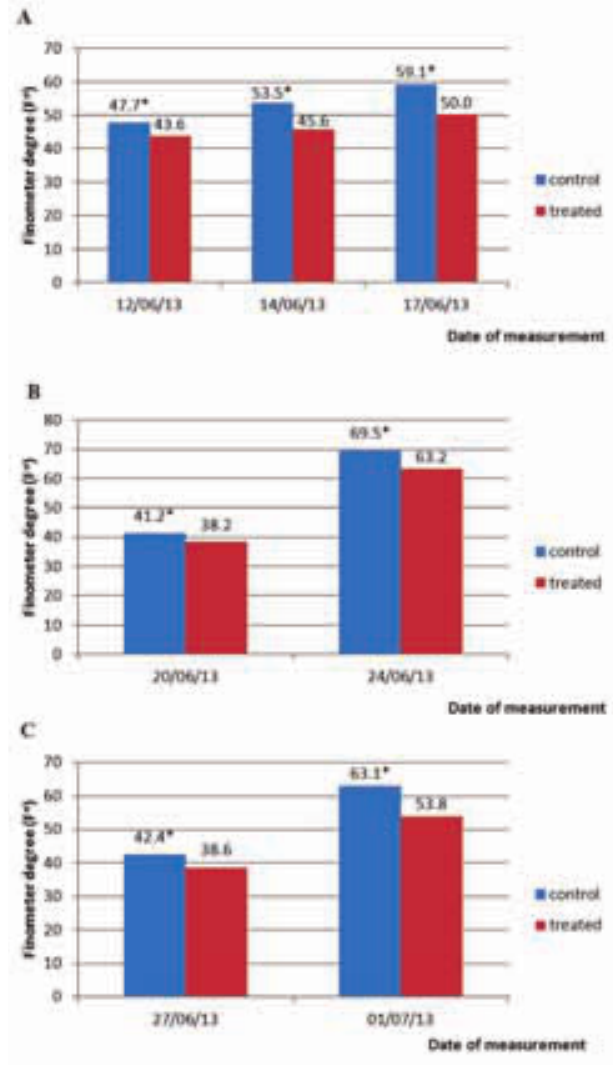
Figure 3. Changes of the tenderness of different green pea varieties in 2013. A: ‘Léda’ B: ‘Zita’ C: ‘Zsuzsi’. * signifi cant differences (P<0.05); e: excellent, I.: First class, II.: Second class, n: outside of class (not suitable for the canning industry)